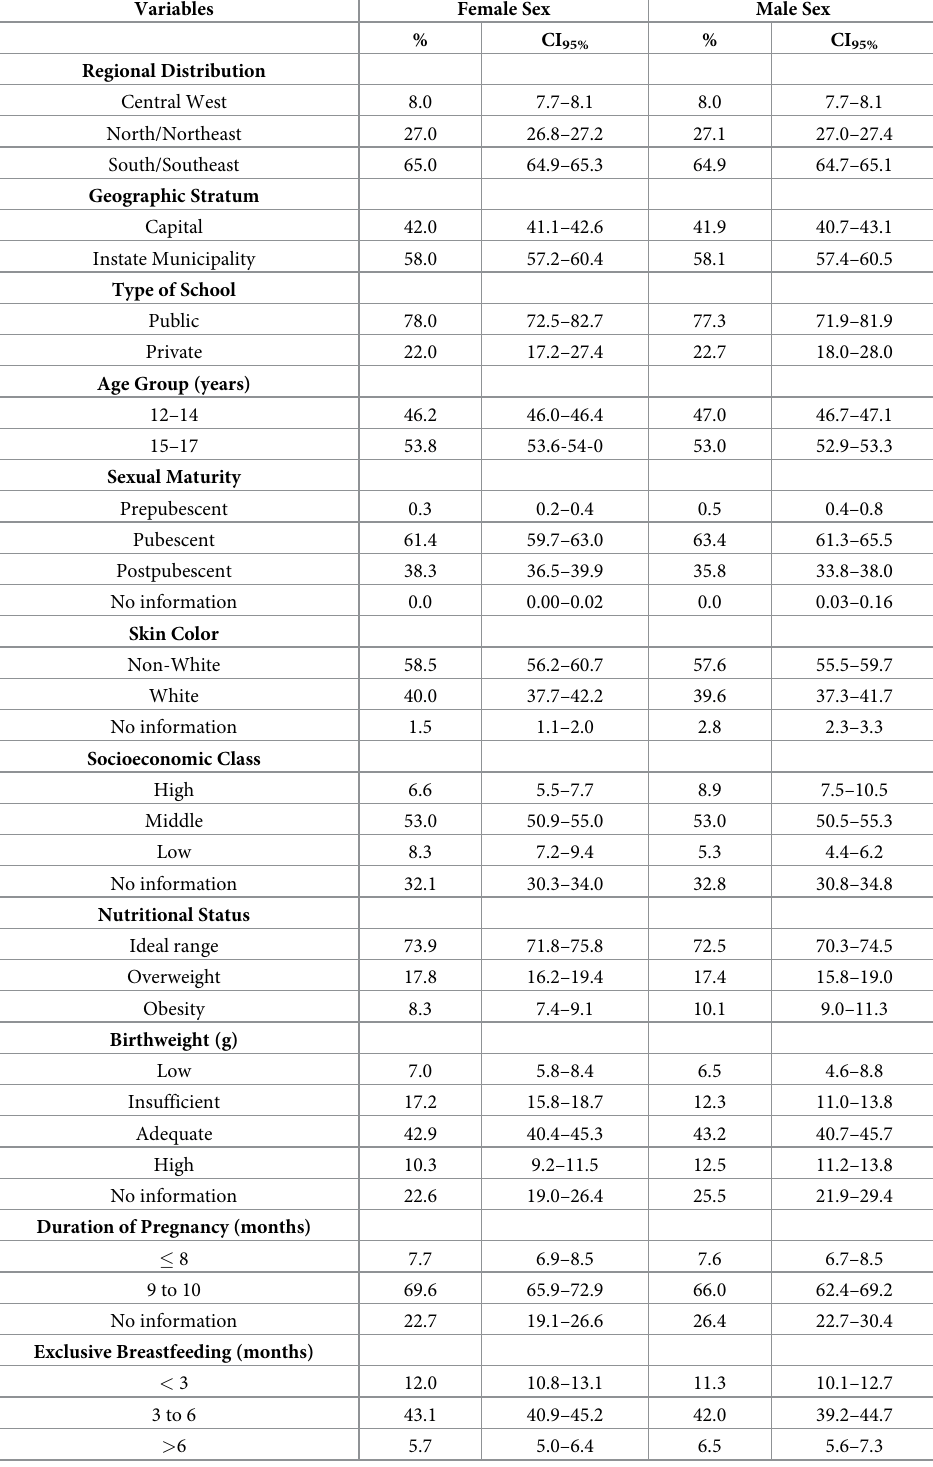
Table 1. Characterization of environmental, sociodemographic, biological, and behavioral variables in early life of Brazilian adolescents stratified by sex, ERICA